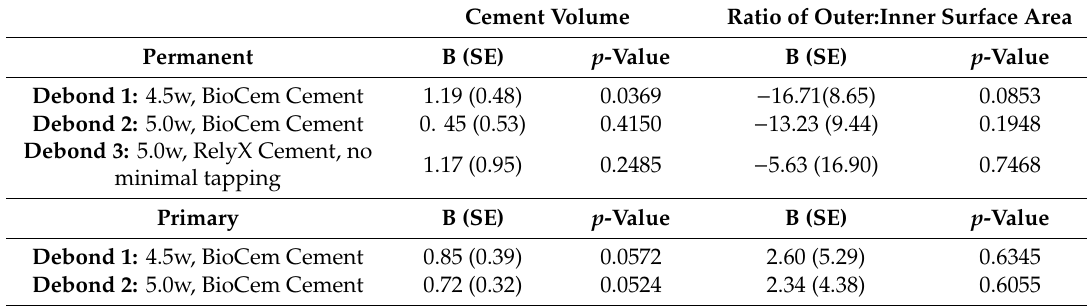
Table 3. Linear regression results for relationship between cement volume, ratio of outer to inner surface area and time to